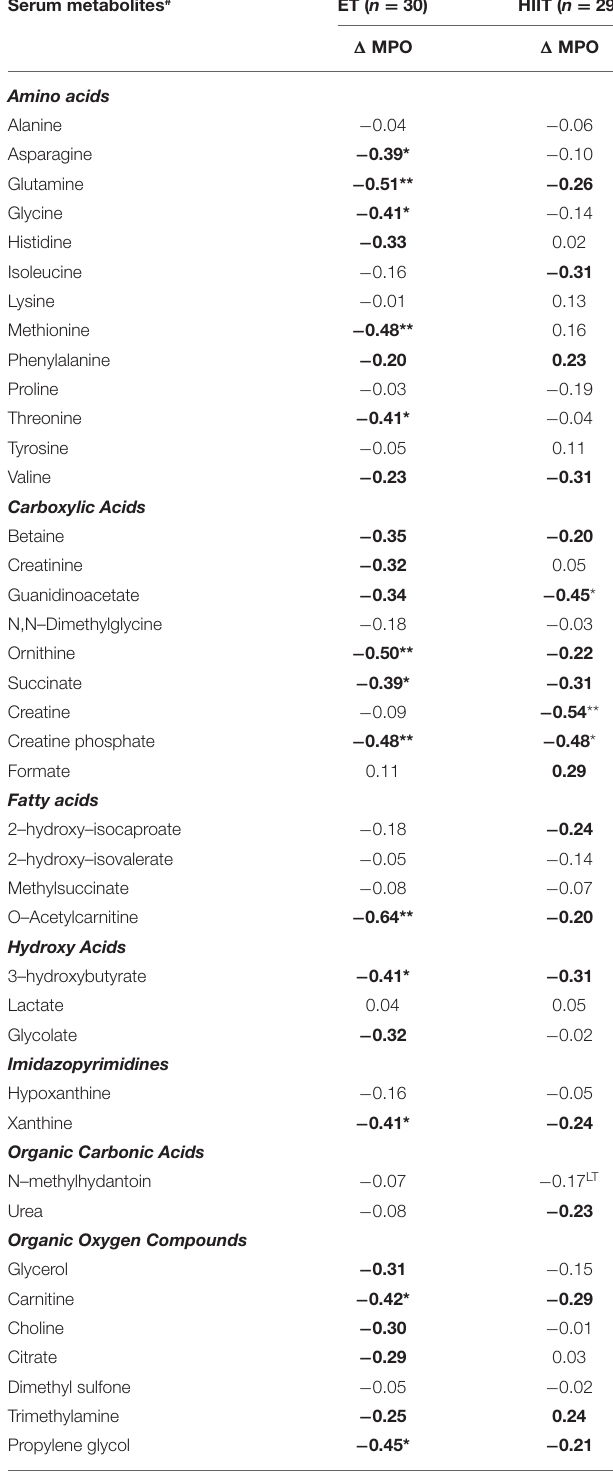
TABLE 1 | Pearson’s correlation coefficients (r) for the association between MPO gains and the pretraining to post–training changes in serum metabolites’ concentration levels metabolic levels in the TIMES